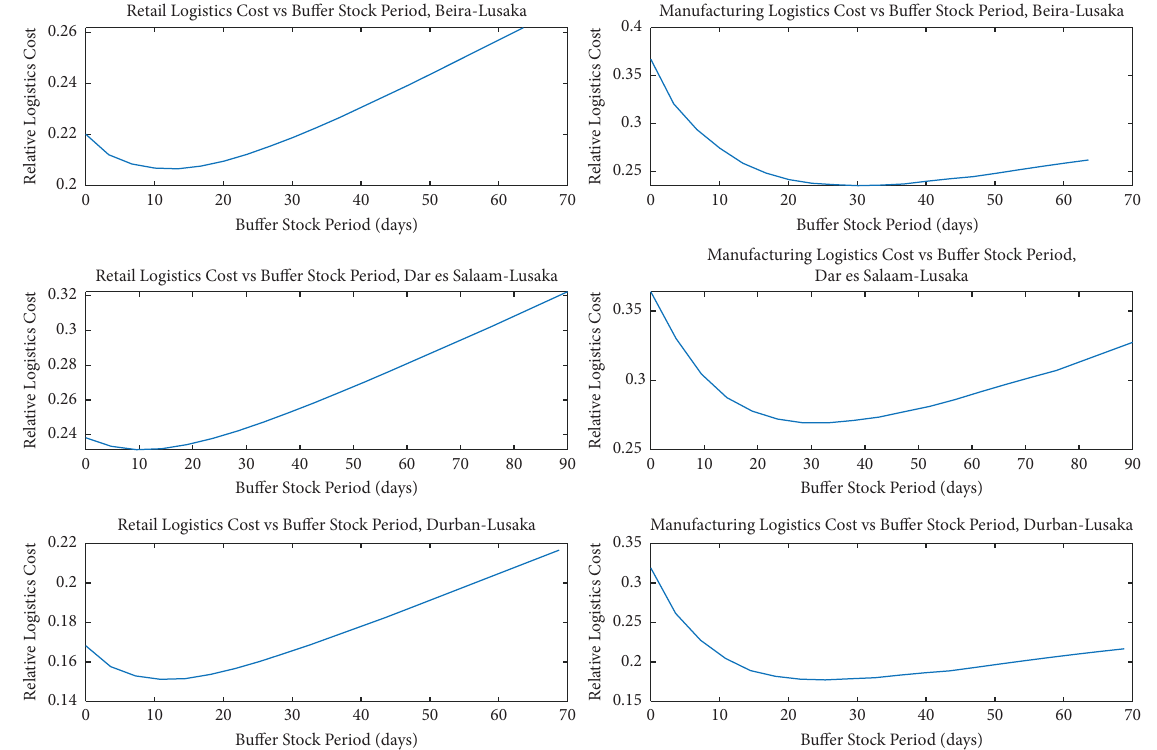
Figure 5: Total logistics costs as a fraction of the cost of cargo for diferent bufer stock periods for three corridors to Lusaka: Beira, Dar es Salaam, and Durban.